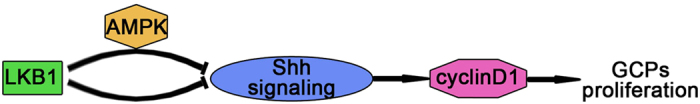
LKB1 function in GCP proliferation during cerebellar development.LKB1 may regulate cerebellar foliation and development by controlling the GCP proliferation via Shh signalling, which controls the G1 cyclins during cerebellar development. In our mutant mice, LKB1 deletion significantly increased the level of Shh signalling, which may increase cyclinD1. These changes resulted in an abnormal increase in GCP proliferation, which caused the cerebellar defects and extra lobules. AMPK likely acts as a mediator between LKB1 and Shh signalling in the LKB1Atoh1 CKO cerebellum.